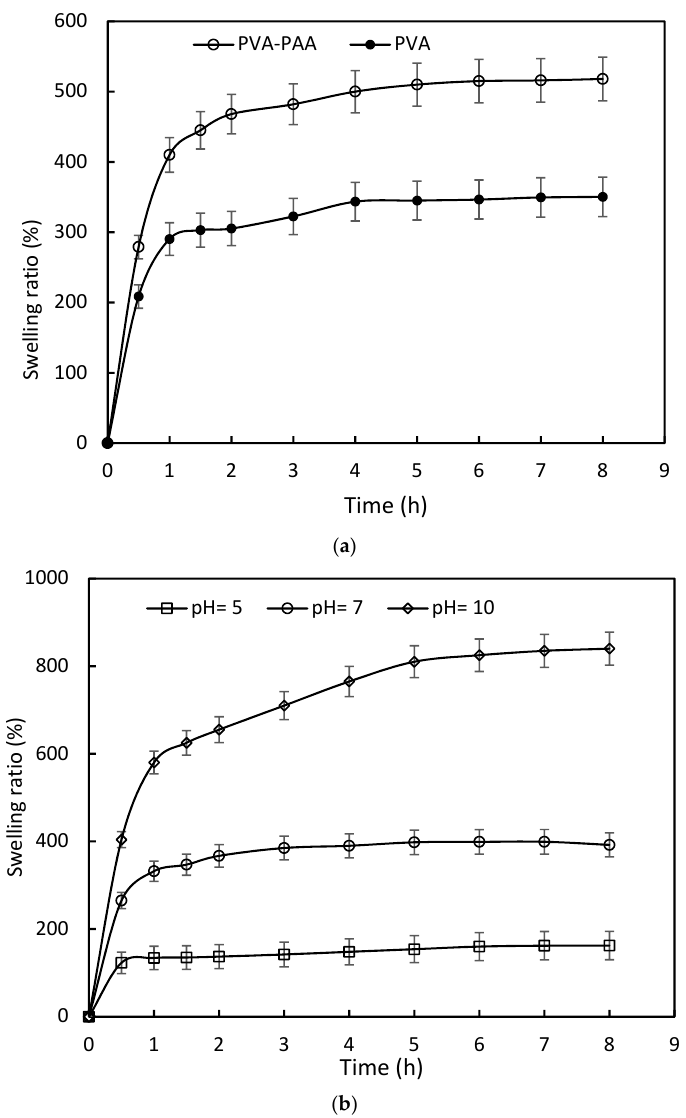
Figure 3. ( a ) Swelling properties of PVA-PAA and PVA samples in distilled water; and ( b ) Kinetics of swelling for PVA-PAA samples at different pH values.